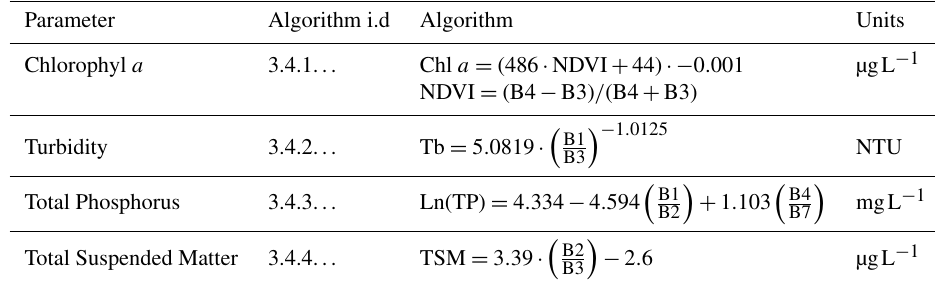
Table 1. Algorithms for retrieval of water quality parameters from Landsat images.